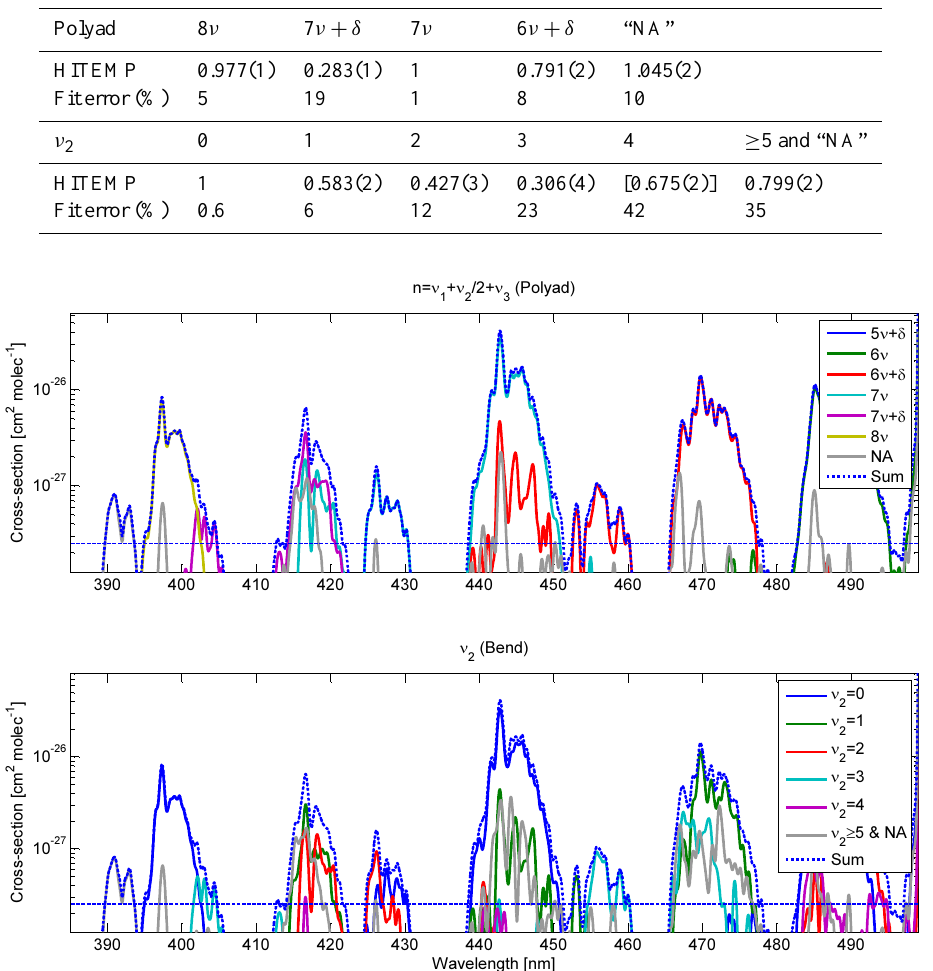
Figure 4. The HITEMP line list for water vapour separated according to polyads and bend mode: “NA” summarises all absorption lines which are listed with the vibrational quantum numbers (ν 1 ,ν 2 ,ν 3 ) = ( − 2 , − 2 , − 2 ) in HITEMP. The dotted horizontal line marks an OD of 1 × 10 − 4 for a dSCD of 4 × 10 23 moleccm − 2